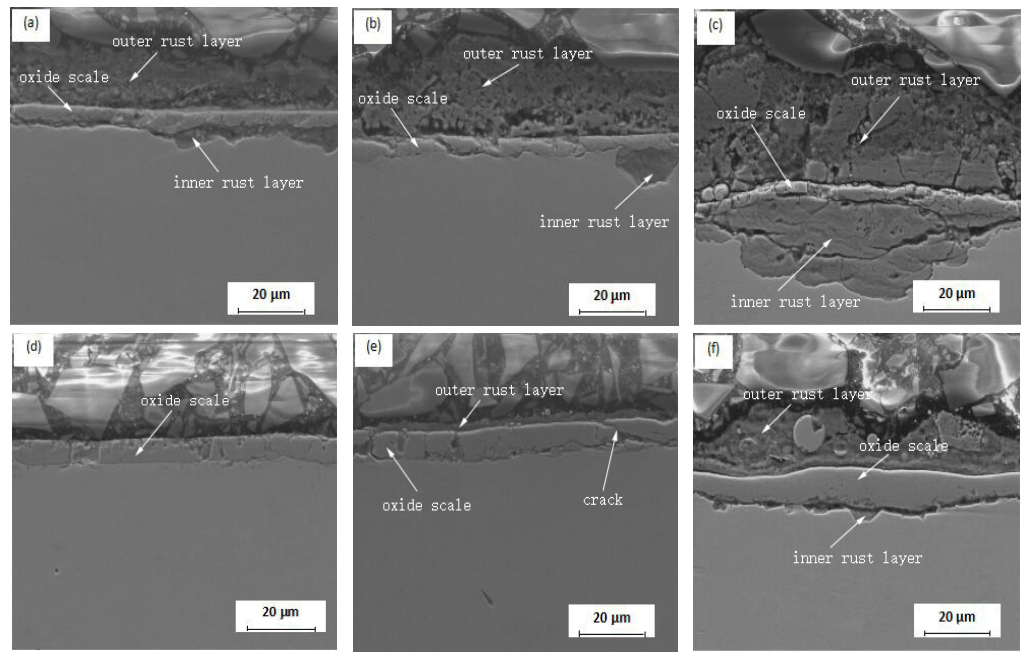
Figure 6. Cross-sectional morphology of rust on oxide scales after different cycles: ( a ) 20 cycles, type I; ( b ) 50 cycles, type I; ( c ) 70 cycles, type I; ( d ) 20 cycles, type IV; ( e ) 50 cycles, type IV; ( f ) 70 cycles, type.